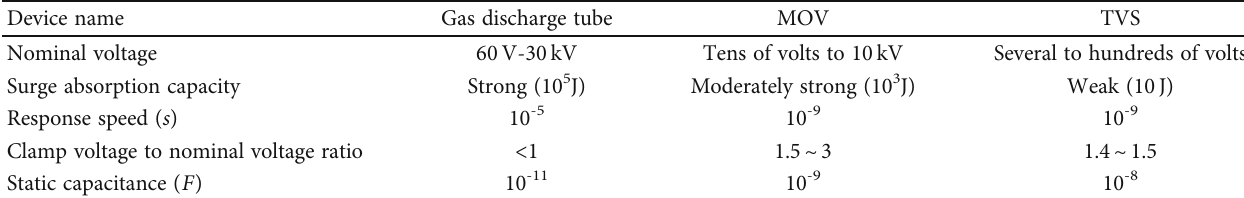
Table 1: Performance comparison of several types of surge protective devices.